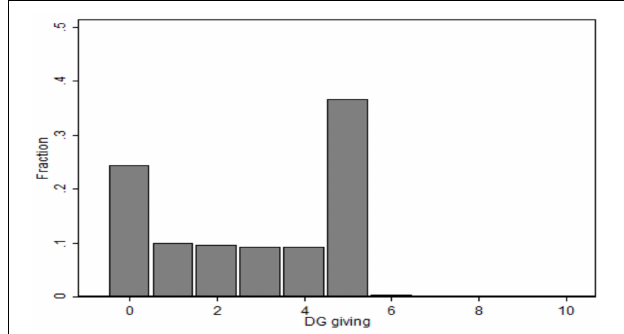
FIGURE 1 | Histogram of individual giving in the Dictator Game.